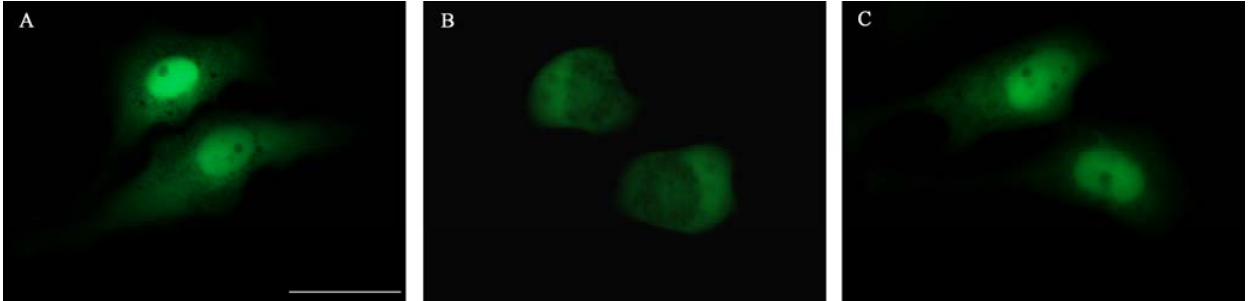
Figure 3. Effect of YNS-PY-F on the nuclear import of HIV-1 integrase in HeLa cells. ( A ) Negative control: EGFP-IN mainly distributed in the nucleus of HeLa cells; ( B ) D77 at 100 μ g/mL: EGFP-IN mainly distributed in the cytoplasm of HeLa cells; ( C ) YNS-PY-F at 200 μ g/mL: EGFP-IN mainly distributed in the nucleus of HeLa cells. The scale bar was 25 μ